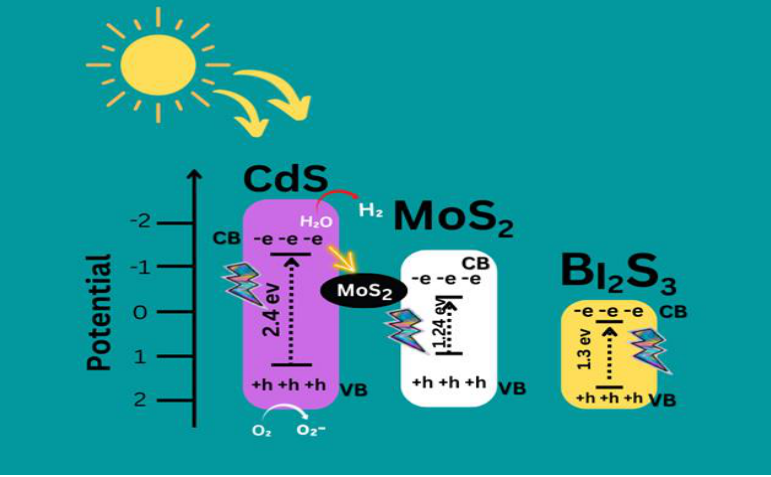
Figure 10. Proposed Mechanism of CdS/MoS 2 /Bi 2 S 3.